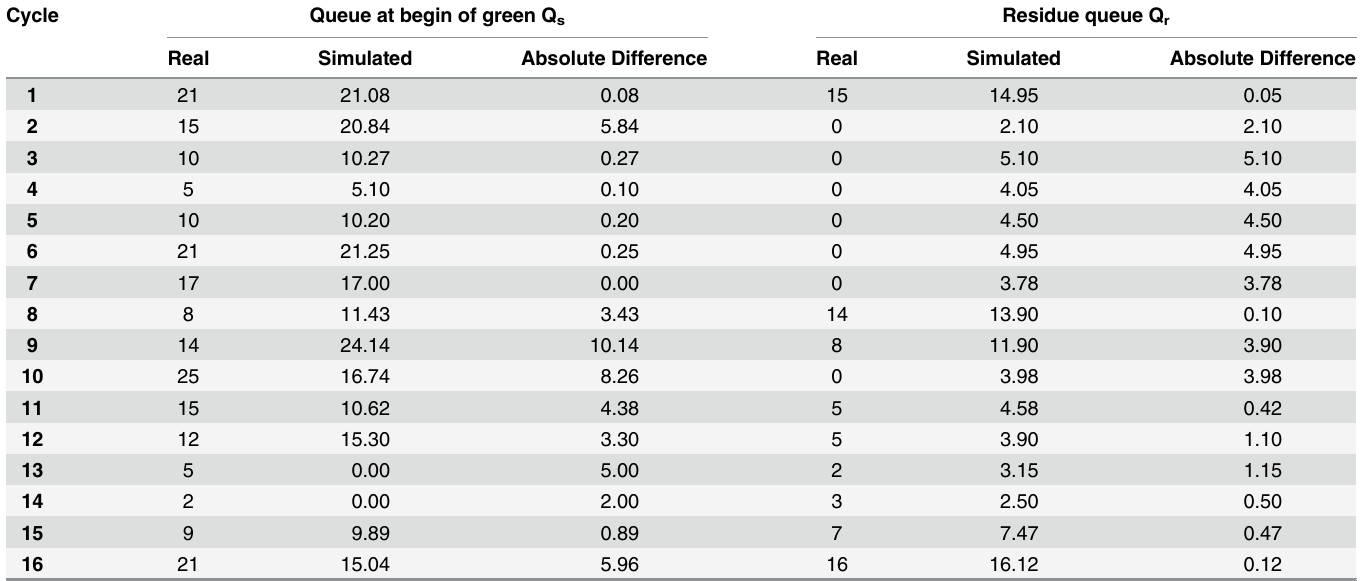
Table 8. Simulated and real queues of Jalan Langat. Cycle Queue at begin of green Q s